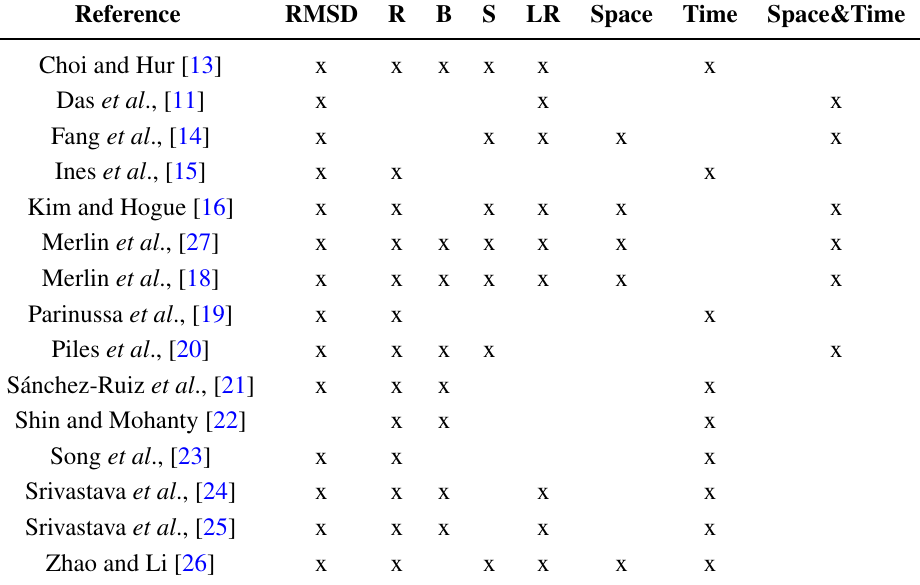
Table 1. Metrics used to assess the error statistics of several recent disaggregation methods: root mean square difference (RMSD), correlation coefficient (R), mean bias (B) and slope of the linear regression (S) between high-resolution disaggregated and fine-scale true soil moisture estimates. The column LR (for low resolution) is checked if error statistics are evaluated against those obtained in the non-disaggregation case: by comparing at high resolution the low-resolution observation with fine-scale true estimates. It is also mentioned whether validation is done in space (on the satellite overpass time), in time (per station) and/or using a mixed spatio-temporal dataset (with several stations on several satellite overpass